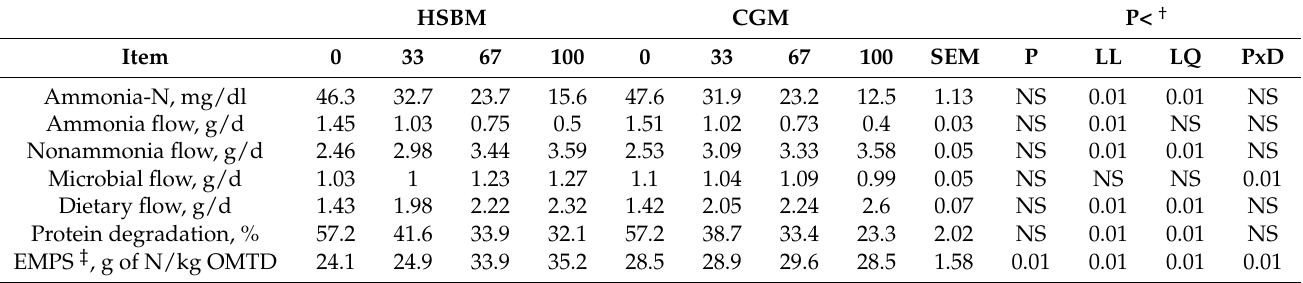
Table 4. Nitrogen metabolism in continuous culture fermenters fed diets containing increasing levels of heated soyabean meal (HSBM) or corn gluten meal